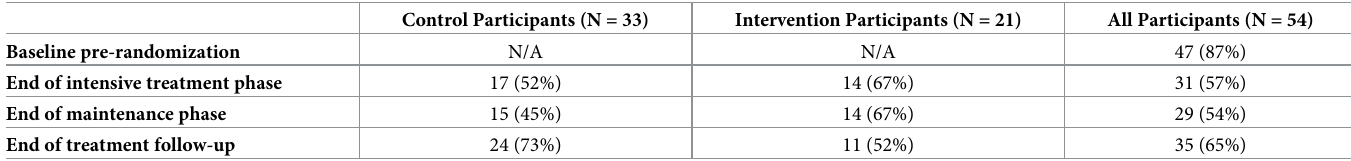
Table 3. Summary of the number and types of participant